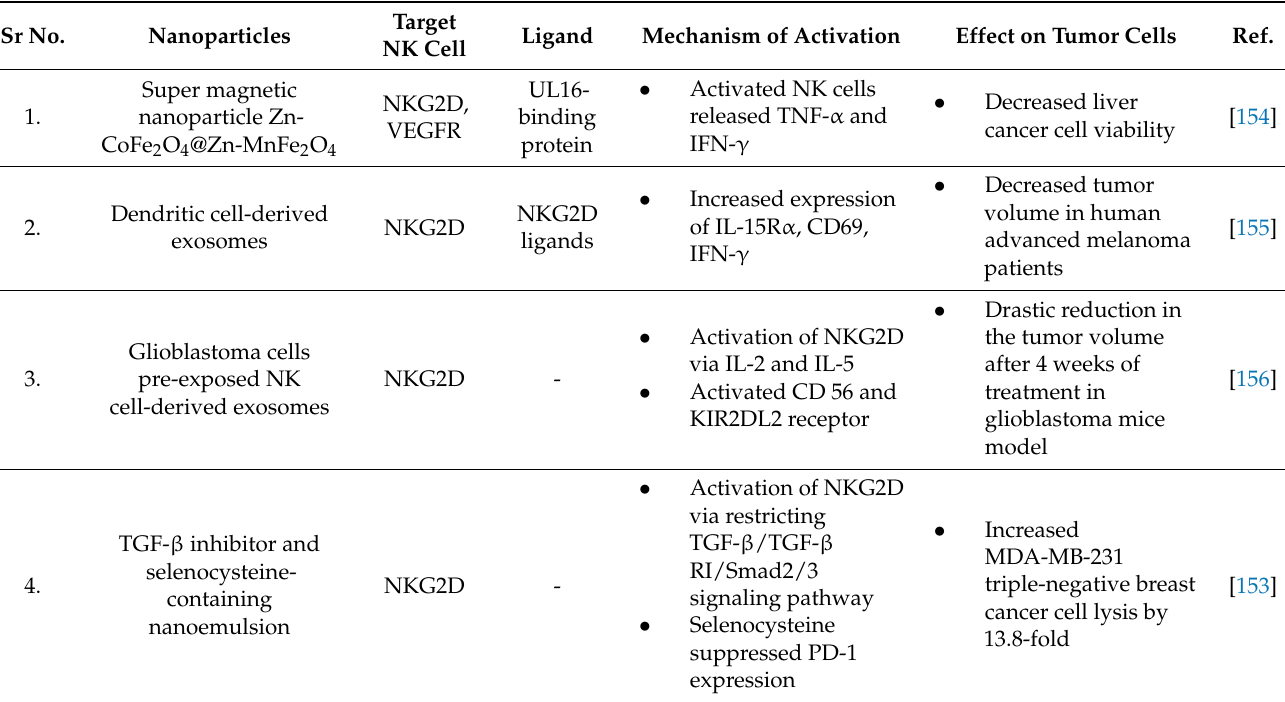
Table 6. Comprehensive information on nanoparticles activating NKG2D